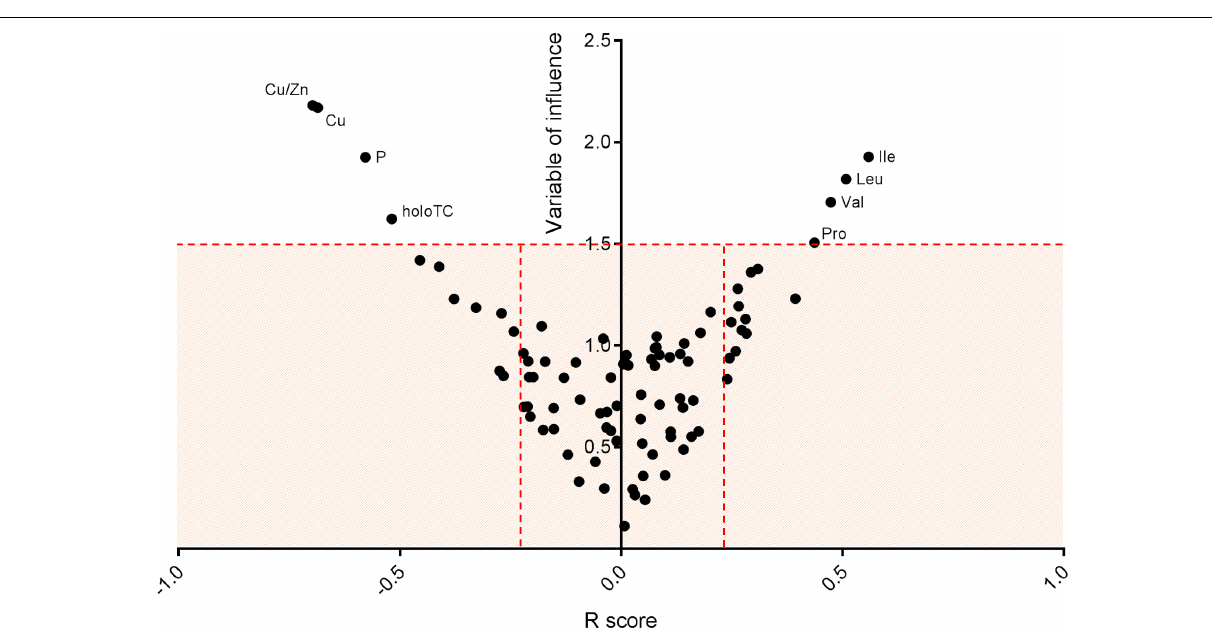
FIGURE 2 | Significant blood nutrient parameters that contribute to sex differences. Representation of variable of influence (VIP) vs. R score. The V-plot was applied to identify the most significant variables (BNP) contributing to the differences driven by sex. Statistically significant variables at the 99% confidence interval were selected using a VIP threshold of 1.5 and r ≥ 0.2. Female BNP were marked by higher values of Cu, Cu/Zn, P, and holotranscobalamin II (active B12) and lower concentrations of isoleucine, leucine, valine, proline and, to a minor degree,